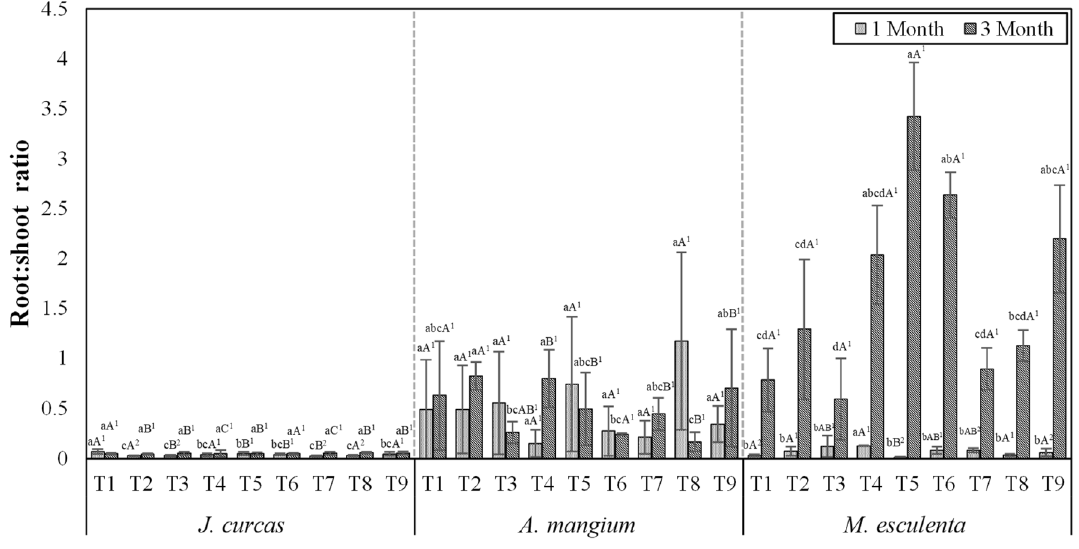
Figure 2. Root/shoot ratio of Cd in study plants. Values followed by the same letter are not significantly different; lower-case letters show the differences in R/S ratios among treatments within the same plant species and growth period (LSD: p < 0.05); capital letters show the differences in R/S ratios among plant species within the same treatment (LSD: p < 0.05); numbers indicate the differences in R/S ratios between growth periods within the same plant species and treatment. T1 = SL, T2 = SBM, T3 = SLBM, T4 = SLVC, T5 = LCM, T6 = LBM, T7 = BMVC, T8 = BMCM, T9 =